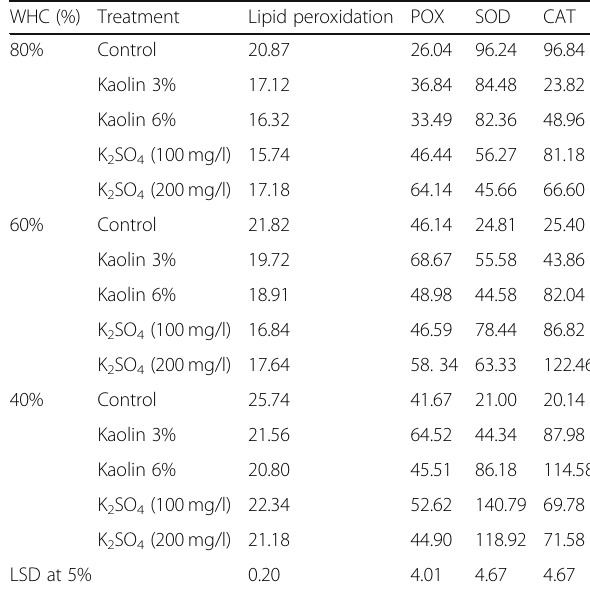
Table 4 Effect of different concentrations of kaolin or K under different levels of water holding capacity on total soluble sugar (TSS), proline, and free amino acid (FAA) (mg/100 g dry weight) and carbohydrate contents (mg/g dry weight) of wheat plants after 75 days from sowing (combined analysis of two seasons)